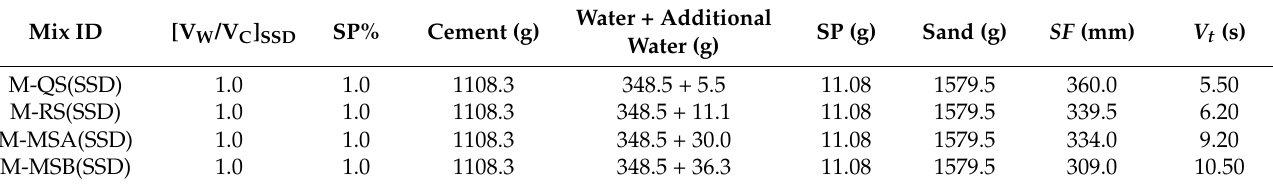
Table 2. Mix proportions for mortar for four kinds of sand.